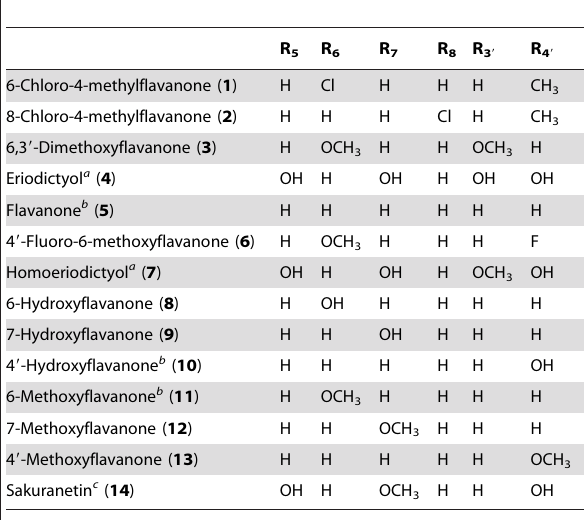
Table 1. Flavanones tested for reduction of activation of hTAS2R39 by